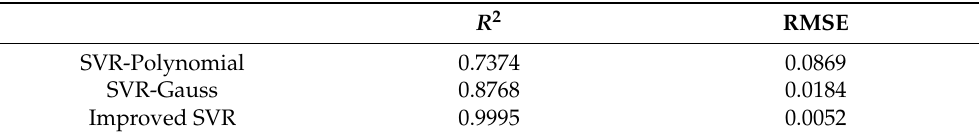
Table 3. The R 2 and